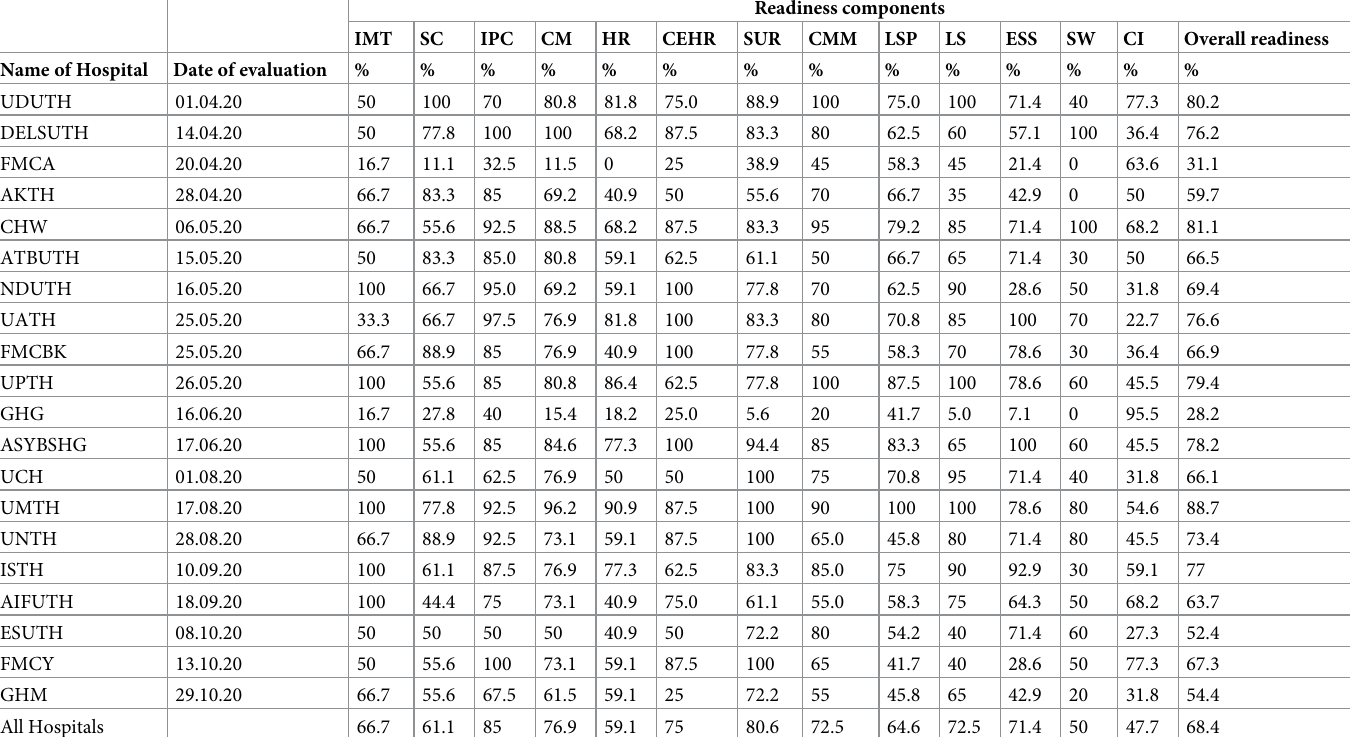
Table 2. Compliance with 13 components of modified WHO COVID-19 readiness checklist among 20 hospitals in